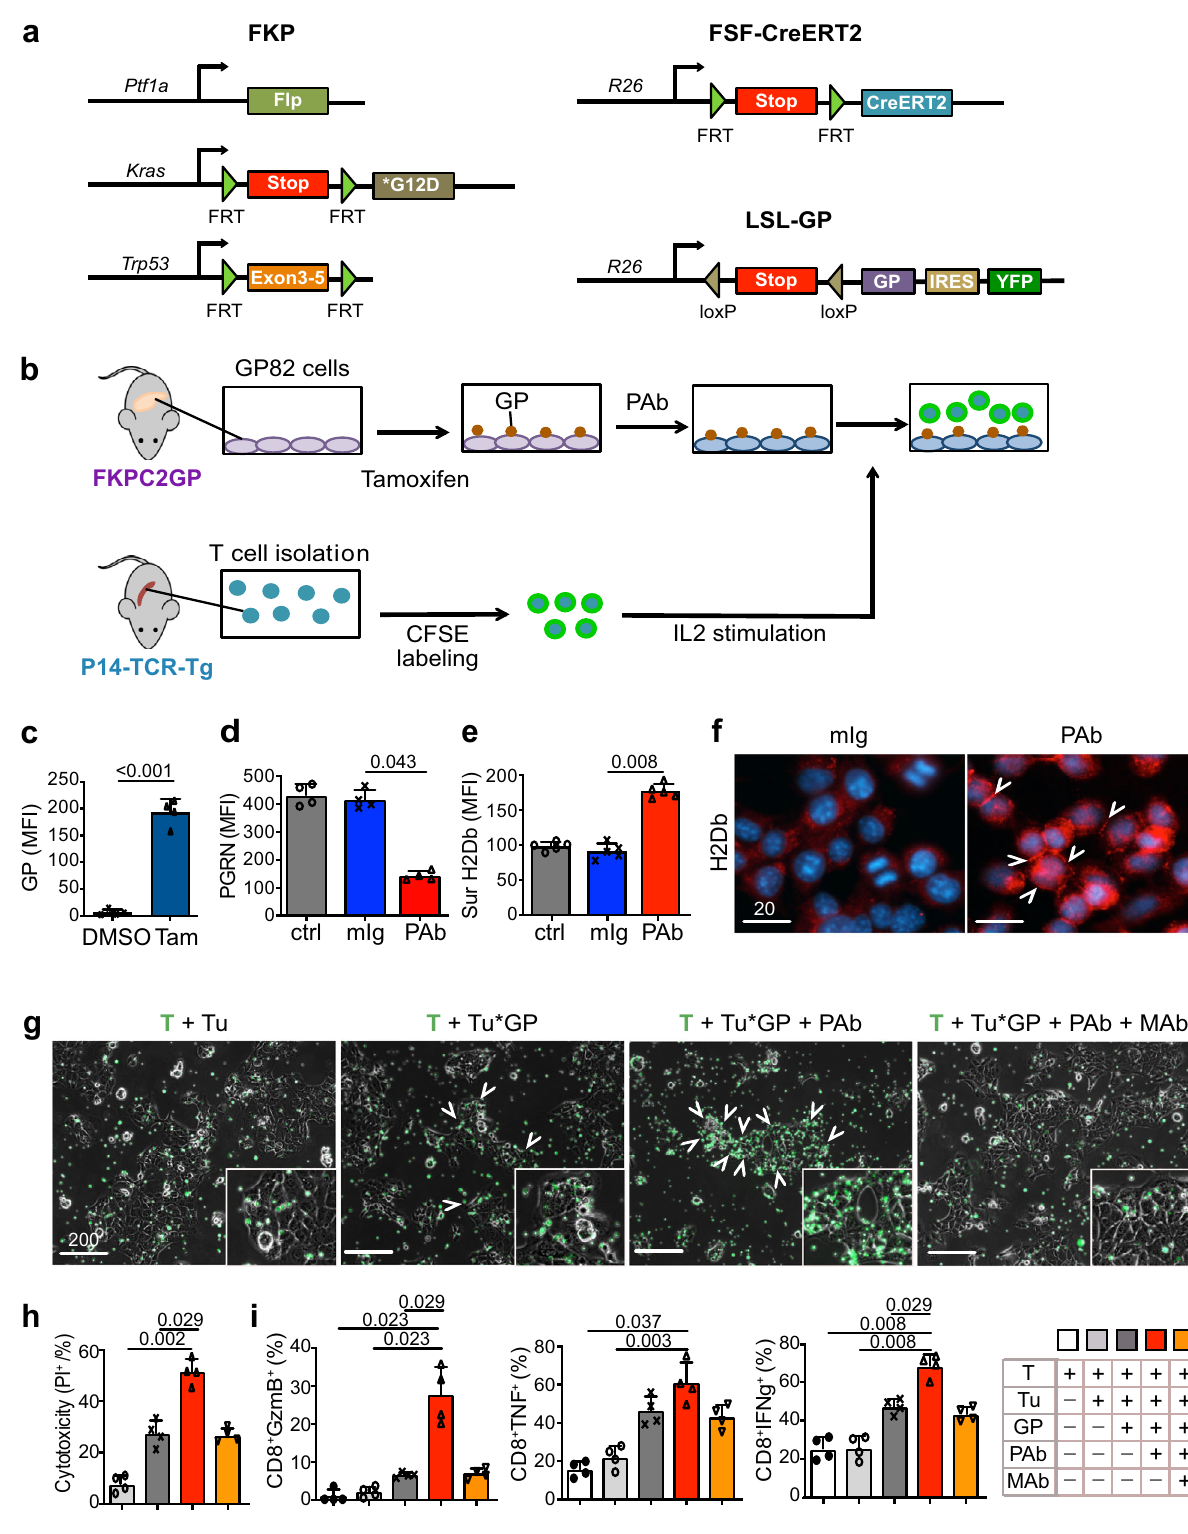
Gene expression data analysis . Transcriptional pro fi ling was performed by using a dataset from Maurer et al. (GSE93326), generated from 65 pairs of tumor epi- thelium and stroma laser capture microdissected samples and 15 bulk tumors 18 . The raw count data of GSE93326 were normalized for library size into counts per million (CPM) by the RLE method implemented in EdgeR (3.28.0) to generate an expression table. We split the data set into stroma and epithelium samples to